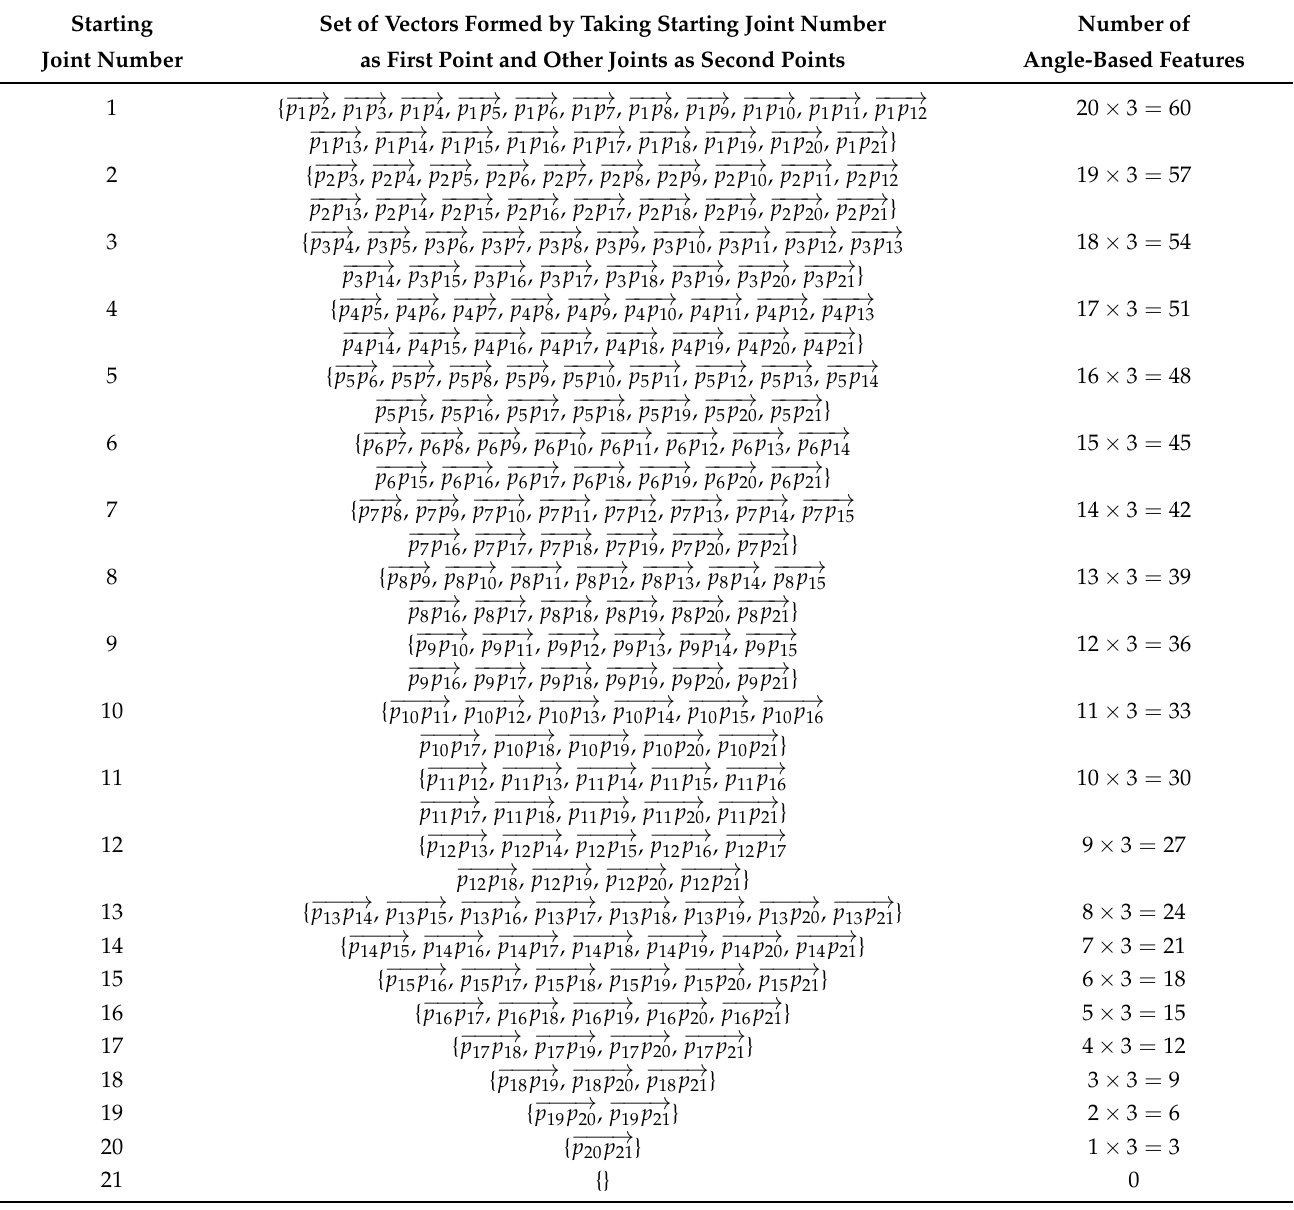
Table 3. Set of vectors obtained when each joint point is considered as a starting point for measuring angle-based features. Here, p i means joint number i